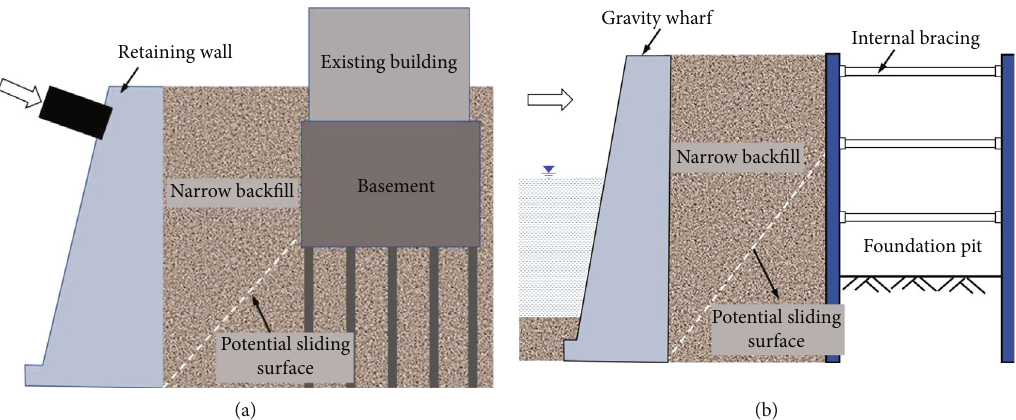
Figure 1: A schematic for narrow width back fi ll behind a retaining wall: (a) near an existing building; (b) near a foundation pit.